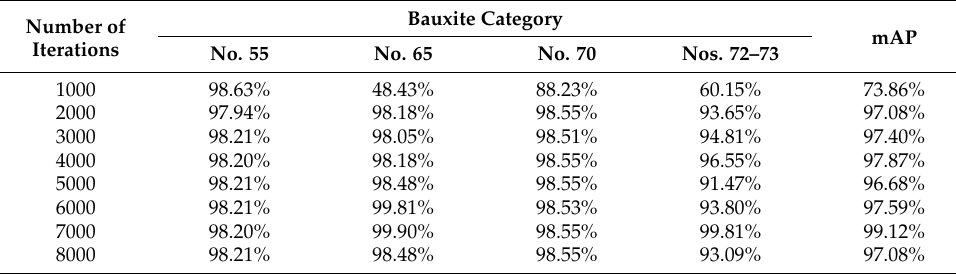
Table 4. Training results of improved YOLOv4 network for balanced category datasets.